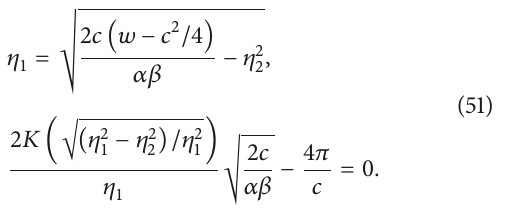
are approximated numerically satisfying the